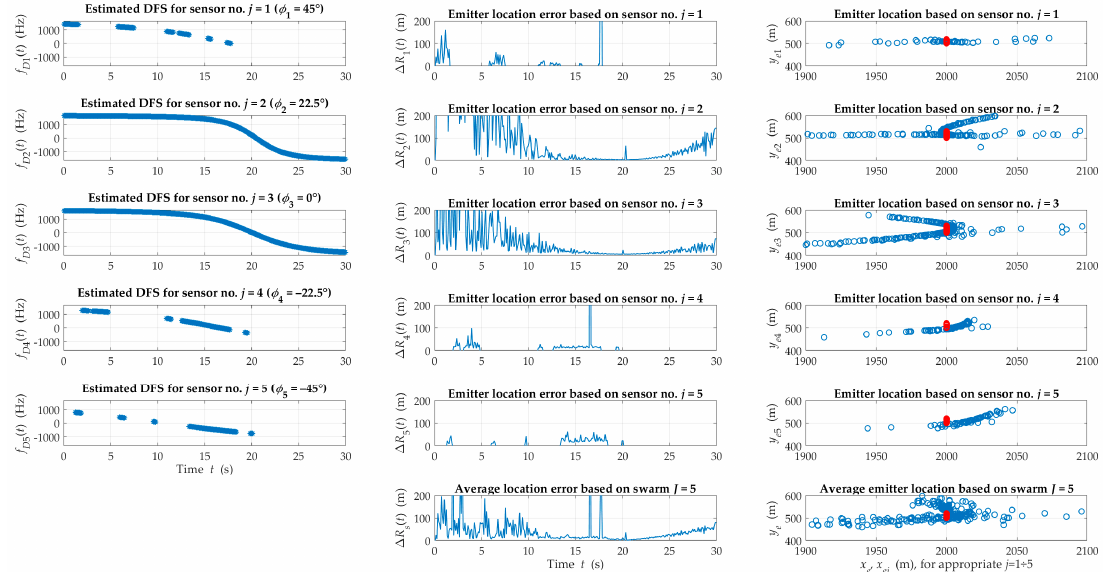
Figure 5. Examples of instantaneous DFS, location errors and the estimated emitter position obtained based on the individual sensors and swarm for a suburban area.